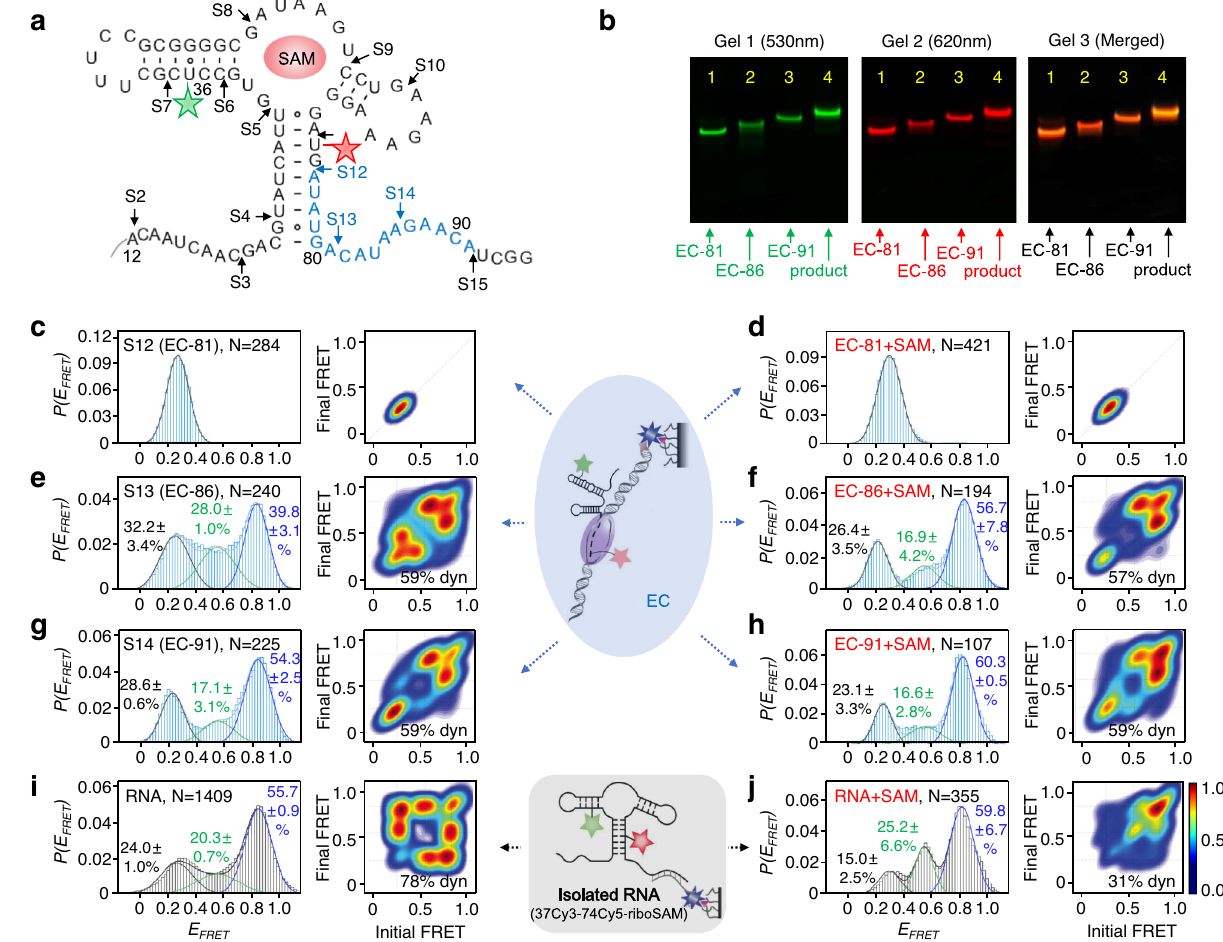
Fig. 3 | smFRET studies of nascent riboSAM in ECs and isolated riboSAM without and with SAM at 2mM Mg 2+ . a 15-step reaction was performed to incorporate Cy3 (green star) and Cy5 (red star) into sites 37 and 74 for structural studies of nascent riboSAM in ECs. The ECs dissociated in steps 12,13, and 14 were used for the co-transcriptional study, and the fi nal product was used for the post- transcriptionalstudy. The nucleotides transcribedinsteps12,13,and 14 are shown in blue. SAM isshown asa red sphere. b Gel shift assays of EC-81, EC-86, EC-91 and the fi nal product (37Cy3-74Cy5-riboSAM). The liquid phase separated by SPE at